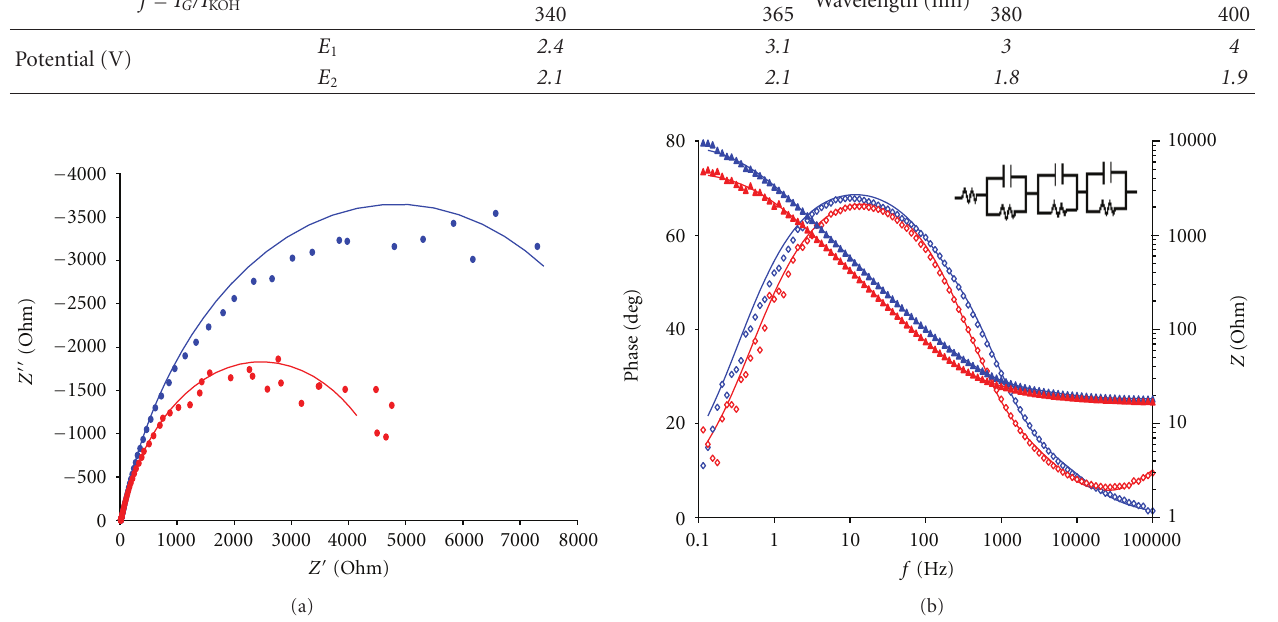
Figure 2: EIS results under irradiation: (a) Nyquist plots; (b) phase angle (empty symbols) and modulus (solid symbols) Bode plots; E = 0 . 5V, λ = 365nm. Blue symbols: in absence of glycerol. Red symbols: in presence of glycerol. Solid lines refer to the model